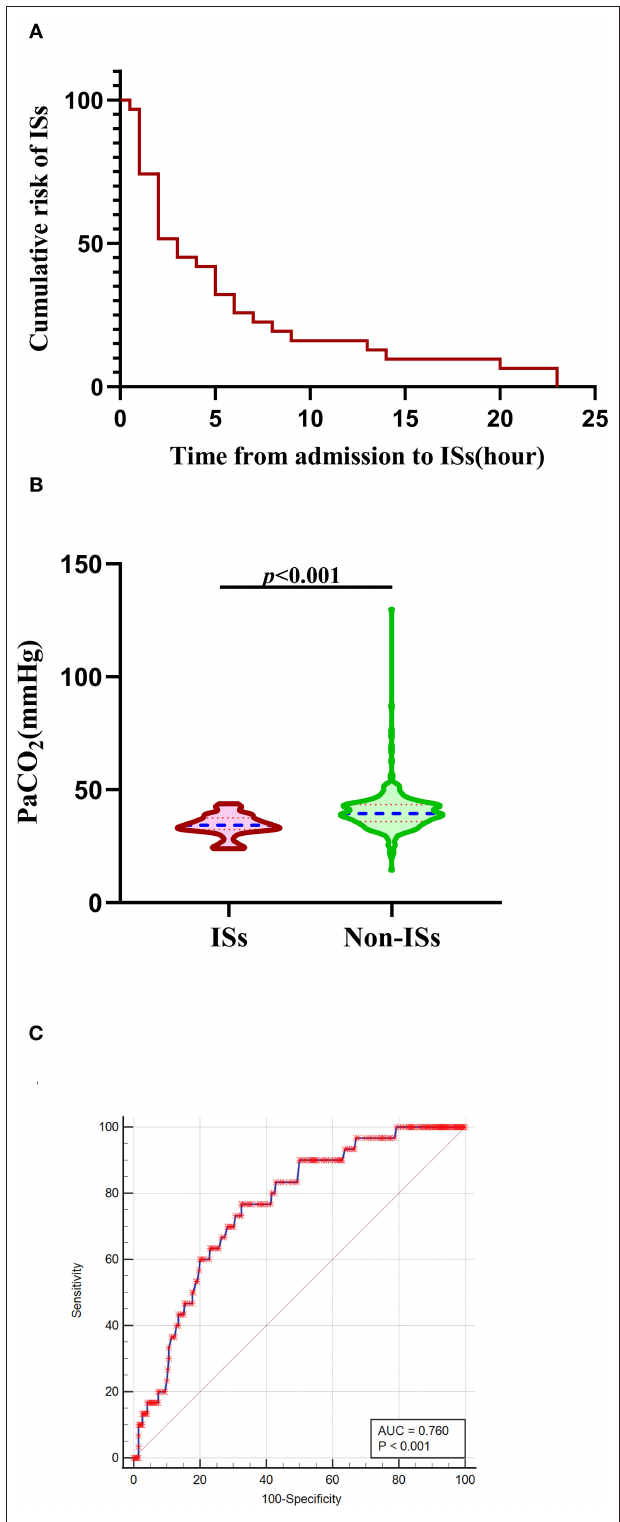
FIGURE 2 | Association of initial PaCO 2 levels with ISs. (A) The cumulative risk of ISs using Kaplan-Meier analysis within 24h after admission in the ISs group.